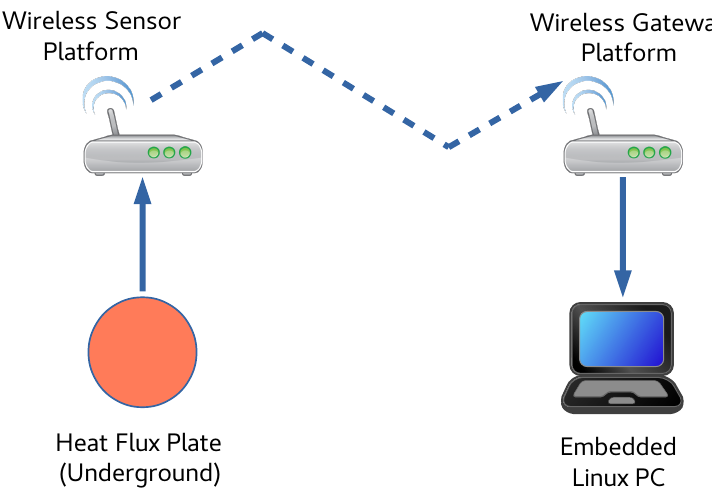
Figure 4. Network structure for wireless data collection of the heat flux